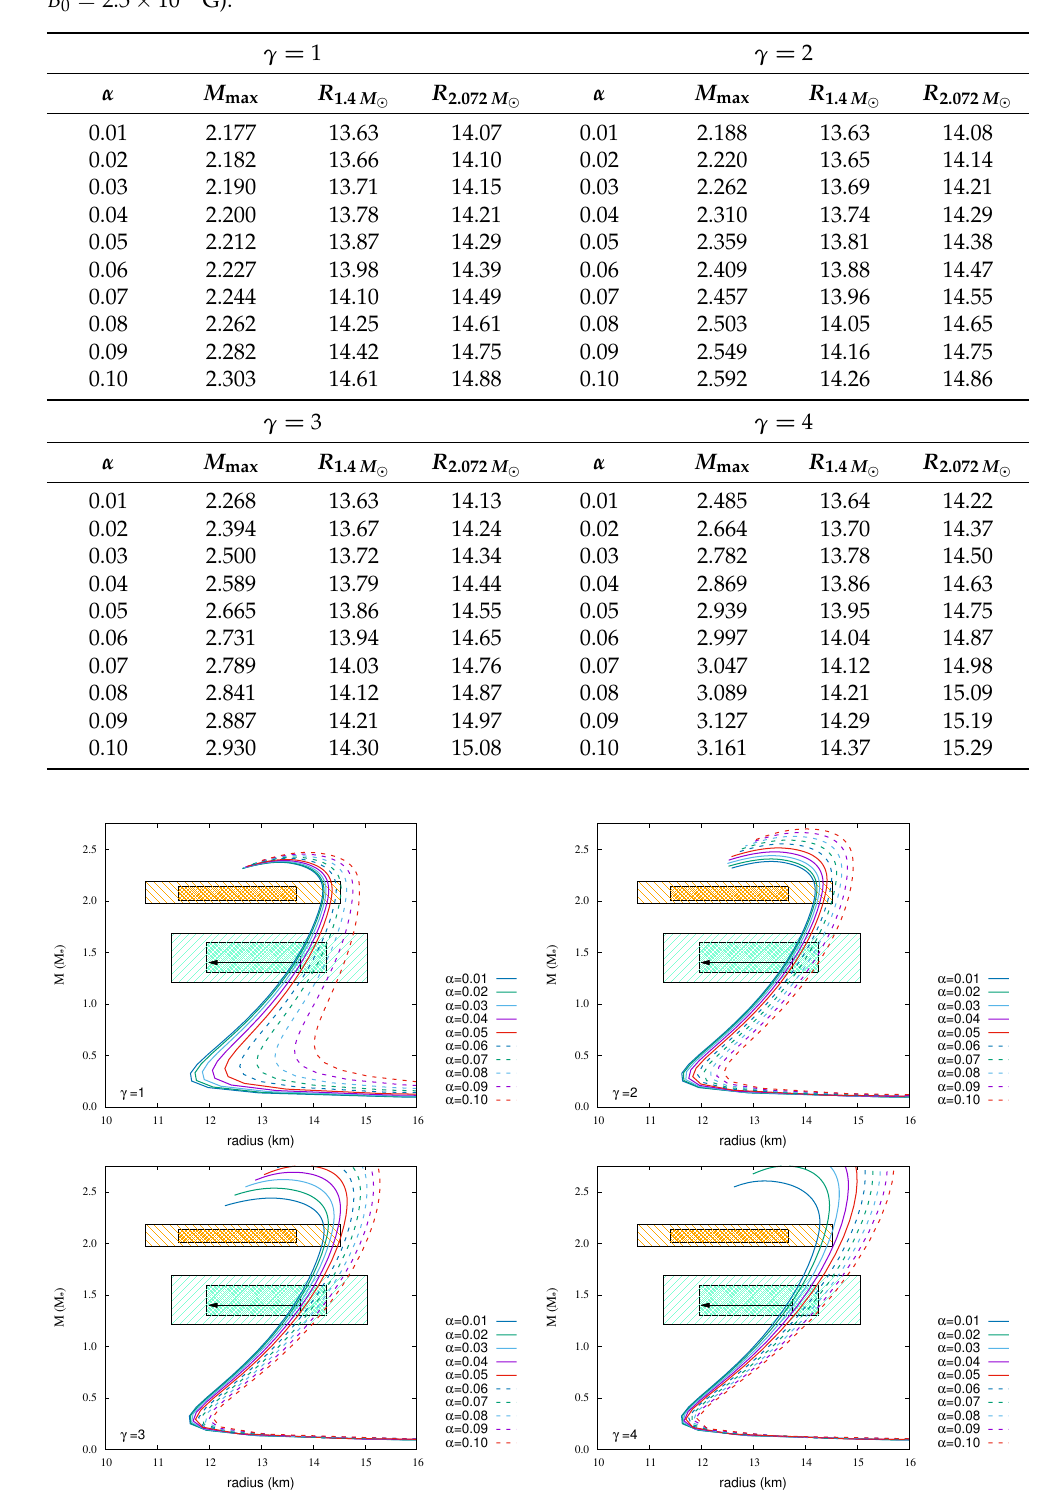
) for NL3 ωρ -a EoS with magnetic fields ( B s = 10 12 G, (cid:12)